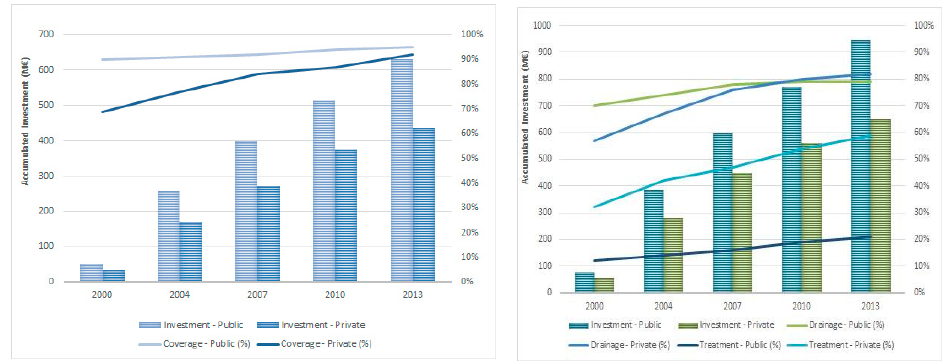
Figure 4. Evolution of water service coverage (left) and wastewater (right) and of the investments made.